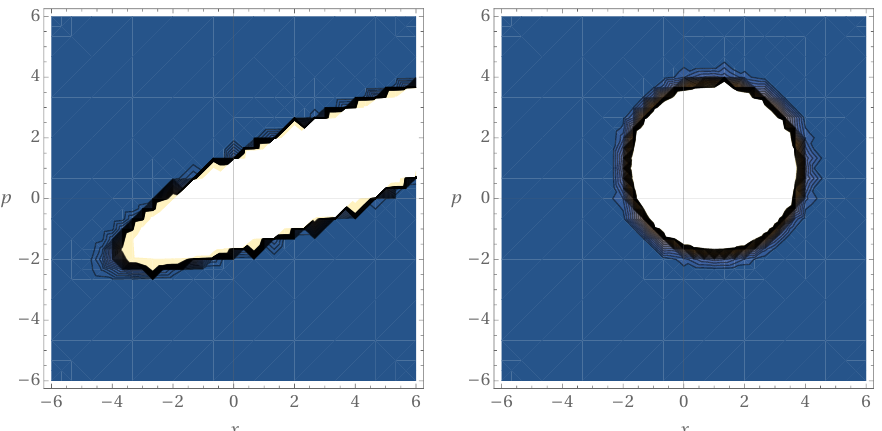
Figure A1. Time evolution of the black hole state Wigner function, with m Pl = ¯ h = ω x = x 0 = 1; p 0 = − 1. The coupling parameter which defines the back reaction is µ = 1.01, with ω y = ω x × 10 5/2 and m y = m Pl × 10 − 5 . We verify that, throughout the various stages of the evolution (corresponding to the various panels), the action of the operators ˆ D ( α ) (displacement operator) and ˆ S ( ξ ) (squeeze operator), produces a full rotation of the displacement center point of the initial Wigner function around the origin of phase space, while various degrees of squeezing affect the shape of the